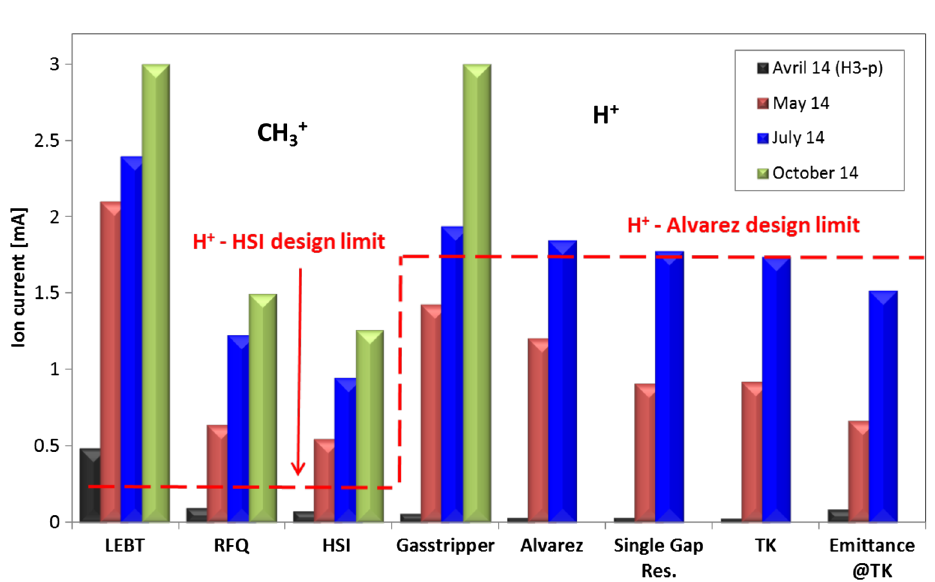
FIG. 2. Layout of the FAIR proton LINAC.